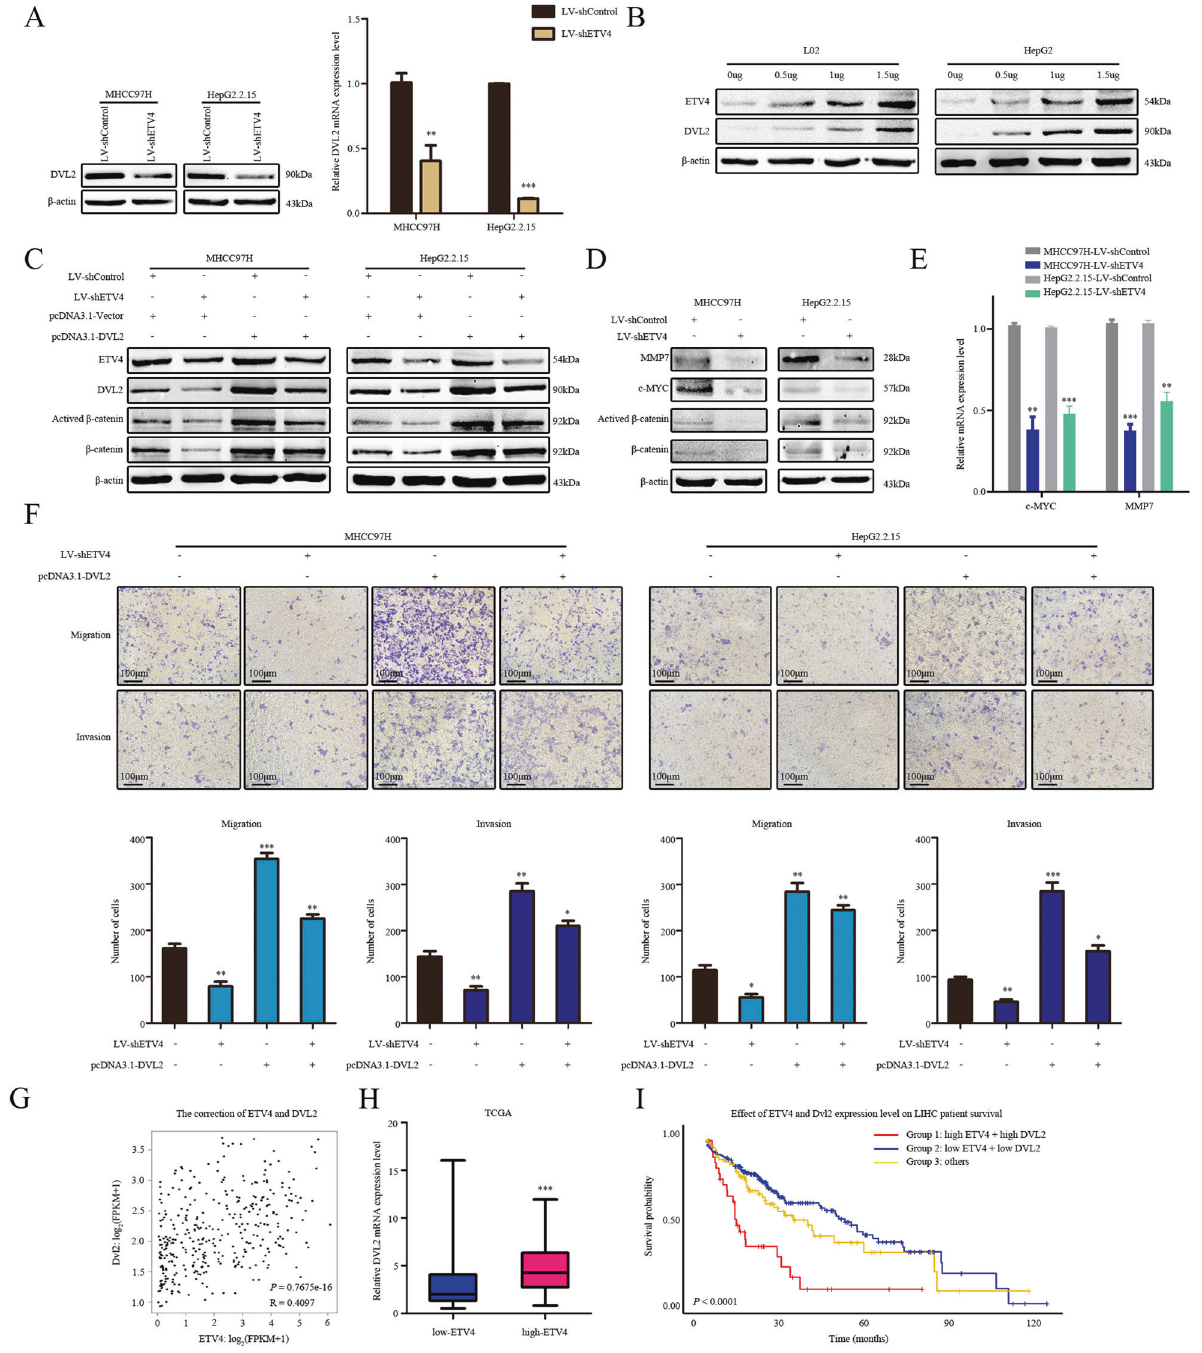
Fig. 5 DVL2 is required for ETV4-mediated HCC metastasis and invasion. A In MHCC97H and HepG2.2.15 cells, ETV4 was stably knocked down, and DVL2 expression levels were detected by WB and quantitative real-time PCR (qRT – PCR) analysis. B In MHCC97H and HepG2.2.15 cells, the DVL2 expression level was detected by WB after transfection with the pcDNA3.1-ETV4 plasmid at different doses. C After the DVL2 construct was transfected into MHCC97H-LV-shETV4 and HepG2.2.15-LV-shETV4 cells, WB was performed to detect the rescue of the indicated protein expression. D WB assay showed that ETV4 regulate the protein expression levels of c-Myc and MMP7 by active β -catenin. E qPCR assays showed that ETV4 regulated c-MYC and MMP7 in transcriptional level. F In vitro, the migration and invasion capacity of MHCC97H and HepG2.2.15 cells were observed by knocking down ETV4 and then rescuing DVL2 expression. G Pearson ’ s correlation coef fi cient was conducted to evaluate the correlation between ETV4 and DVL2 mRNA level. The scatter plots showed the correlation of R = 0.4097 and P < 0.0001. H The positive relationship between the ETV4 and DVL2 expression was exhibited in 140 HBV-positive HCC patients. I The patients were divided into three groups as follows: group 1: high ETV4 + high DVL2, group 2: low ETV4 + low DVL2, and group 3: others. The combined prognosis analysis of ETV4 and DVL2 showed that group 1 had worse overall survival than the other two groups of HCC patients ( P < 0.001).